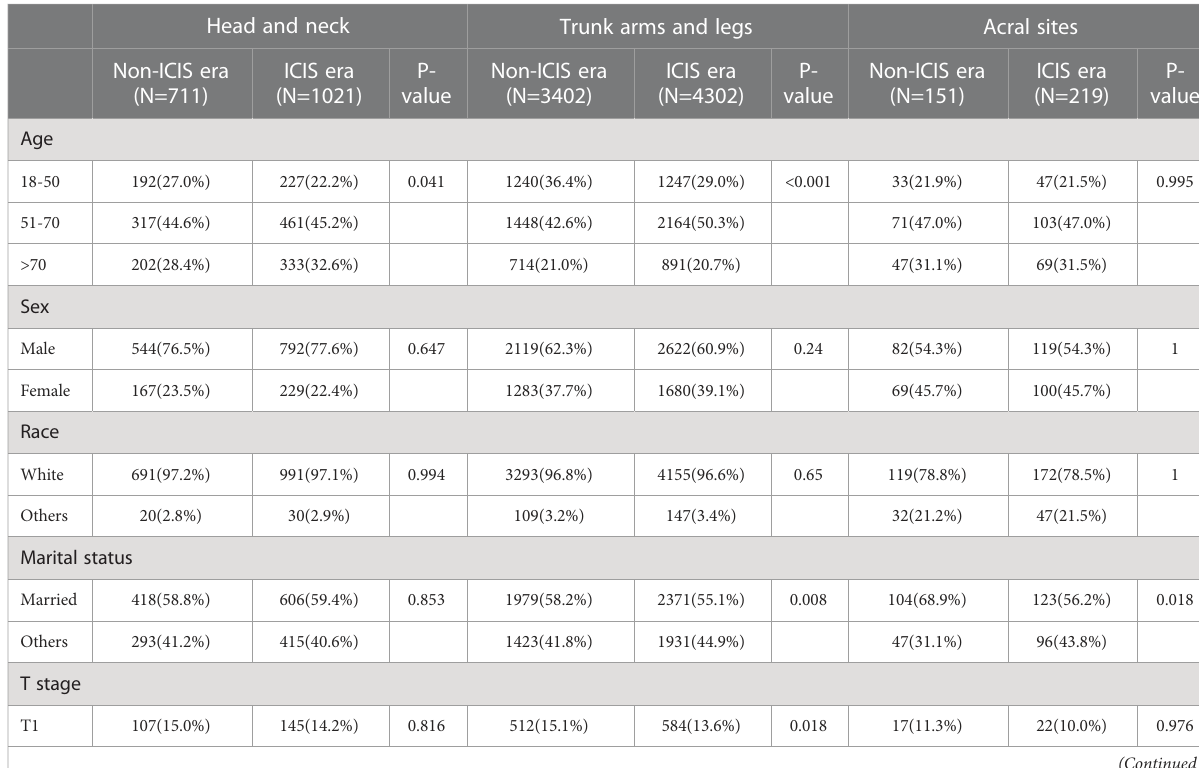
TABLE 1 Baseline characteristics of metastatic melanoma